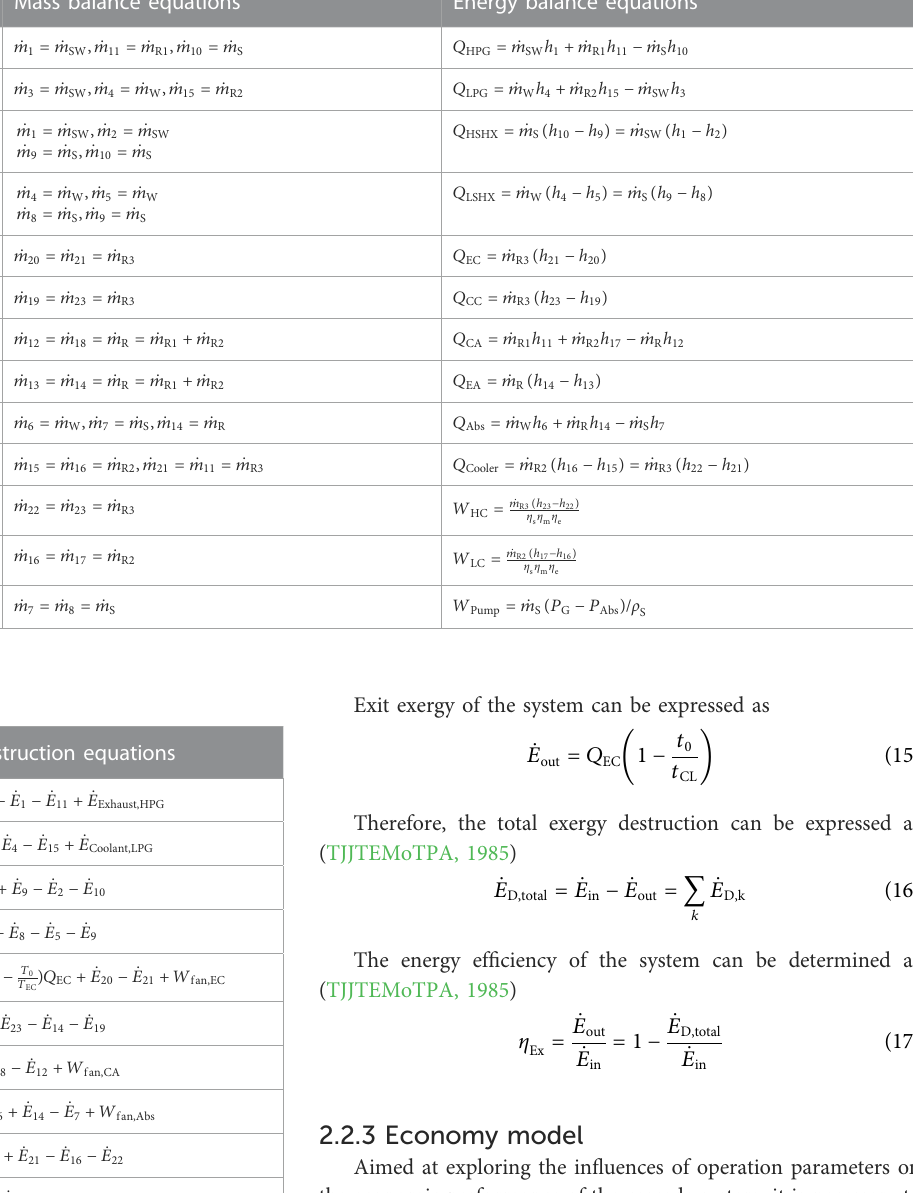
TABLE 1 Energy equations of the cascade refrigeration system. Components Mass balance equations Energy balance equations